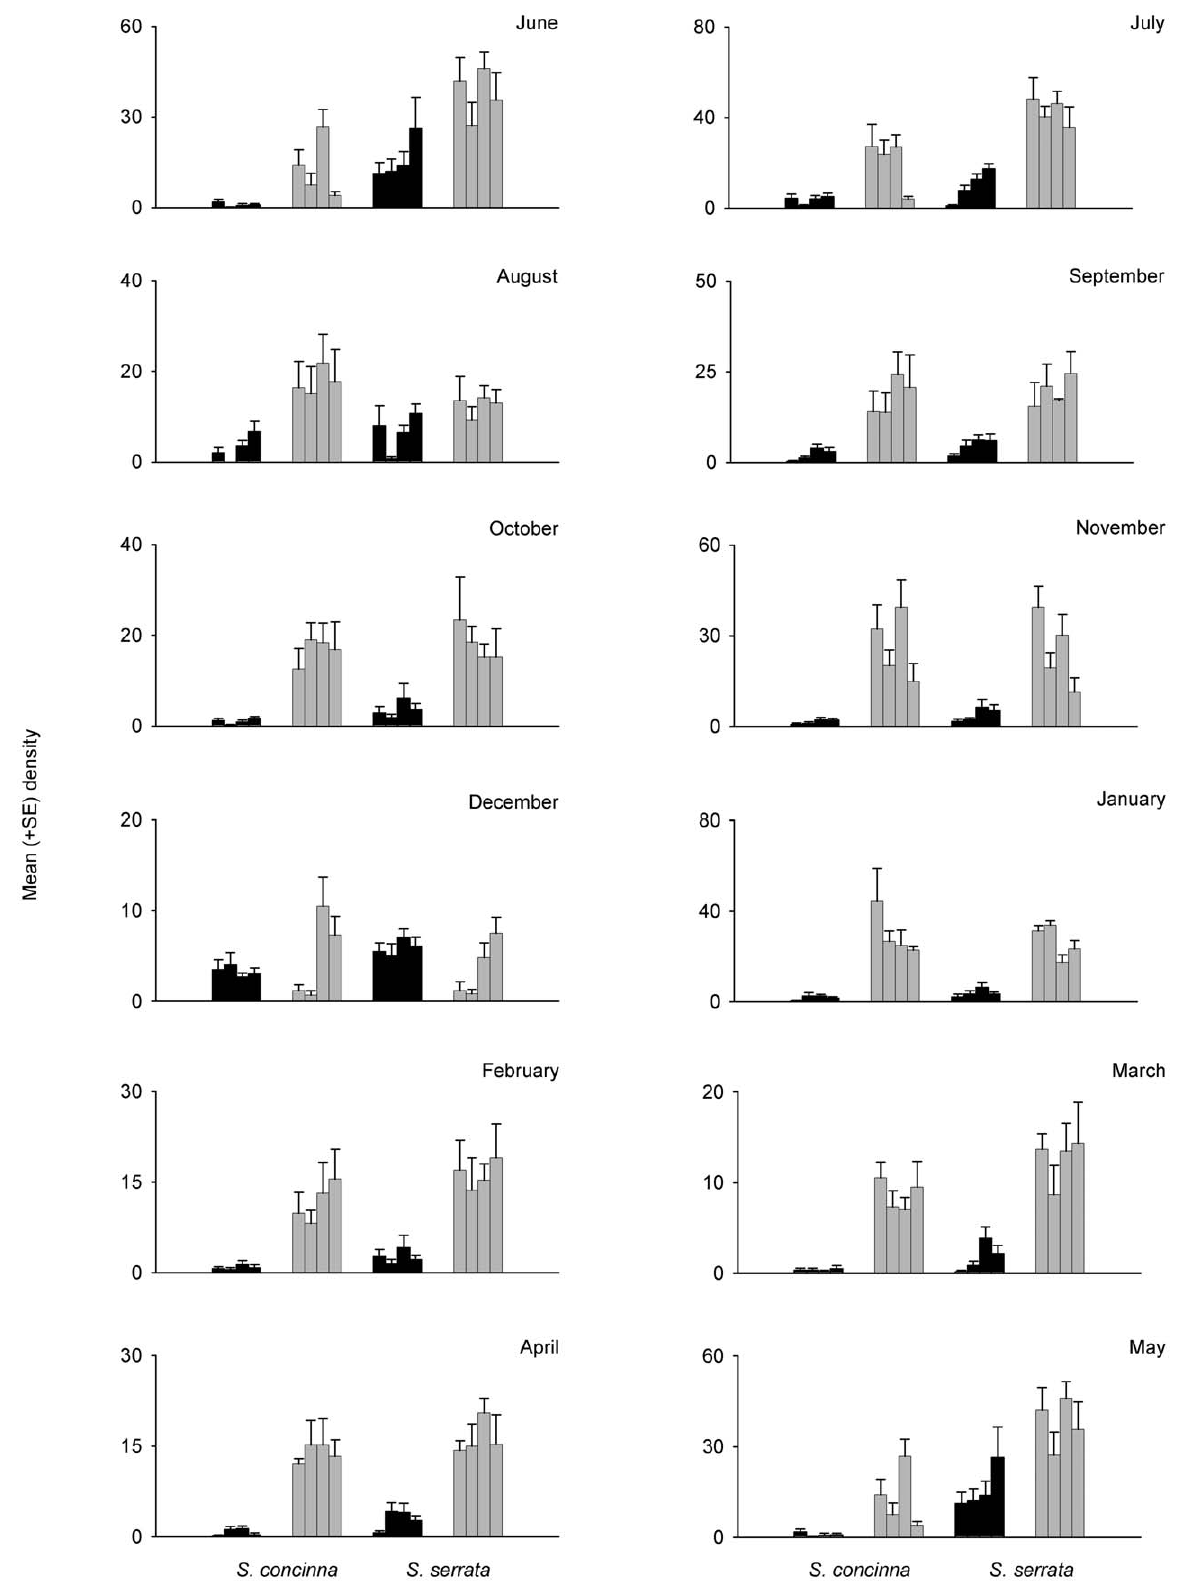
Figure 5. Mean ( + SE; n =6) density of juvenile Siphonariaconcinna and S.concinna in small (black bars) or large patches (grey bars) in the Eastern Cape each month from June 2009 to May 2010.